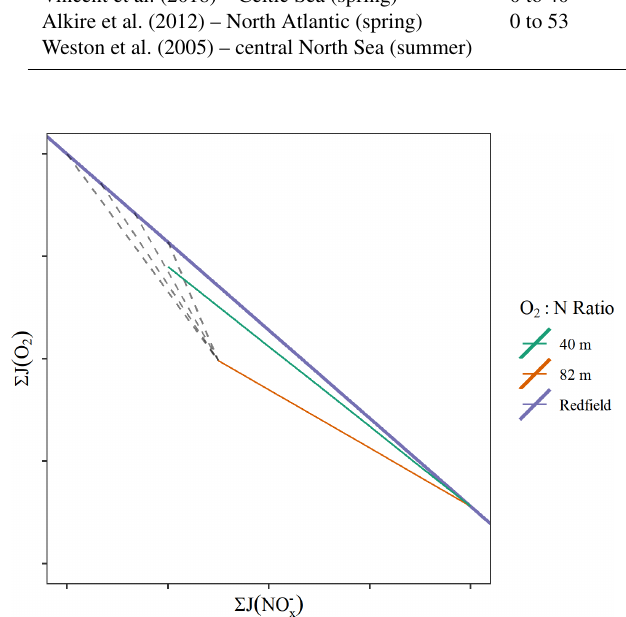
Figure 5. Conceptual diagram which shows how the observed O 2 : N ratios (shown with coloured lines) can be explained by the presence of any number of simultaneous remineralisation processes (dashed